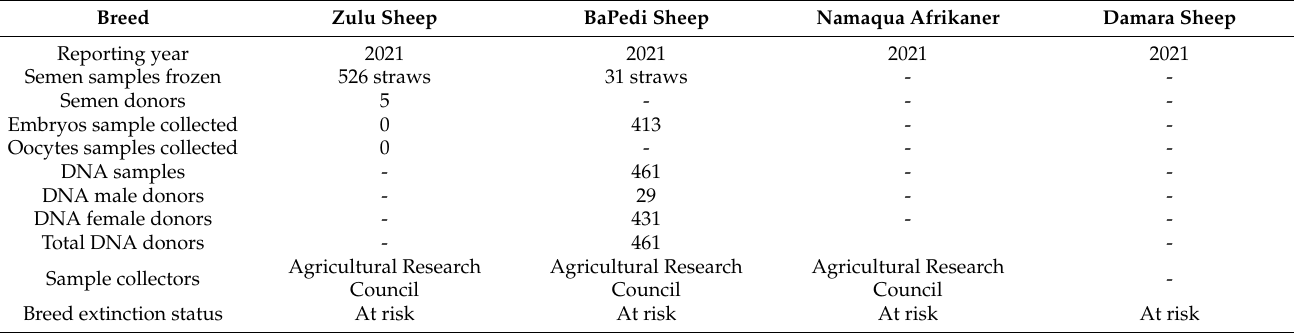
Table 6. In vitro conservation of South African indigenous sheep breeds [16].